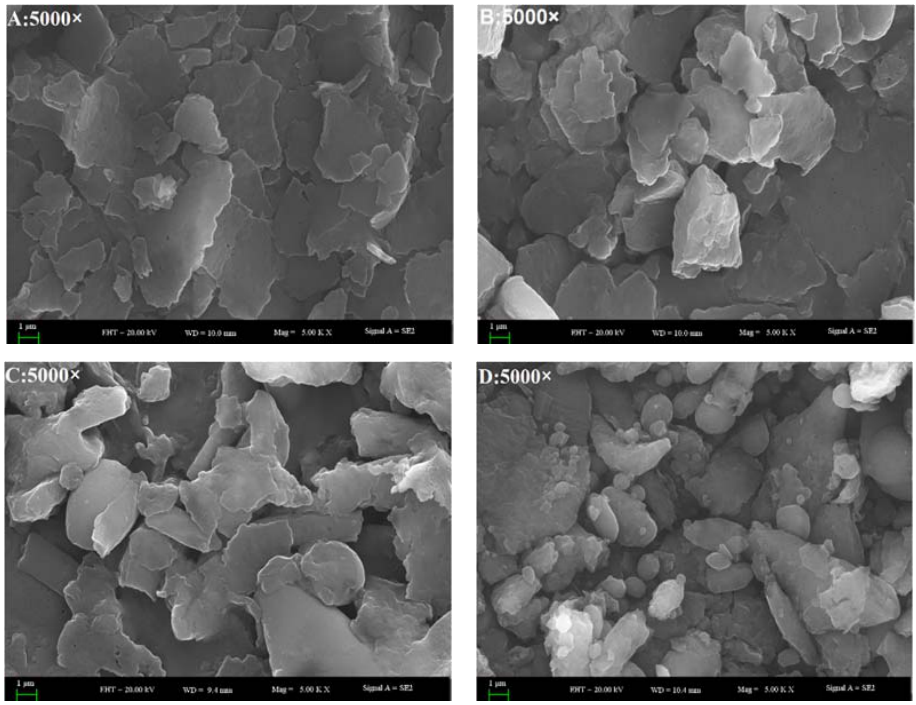
Figure 3. The SEM images of four types of BMP from water extract. ( A ) SBMP; ( B ) BBMP; ( C ) HBMP; ( D ) CBMP.